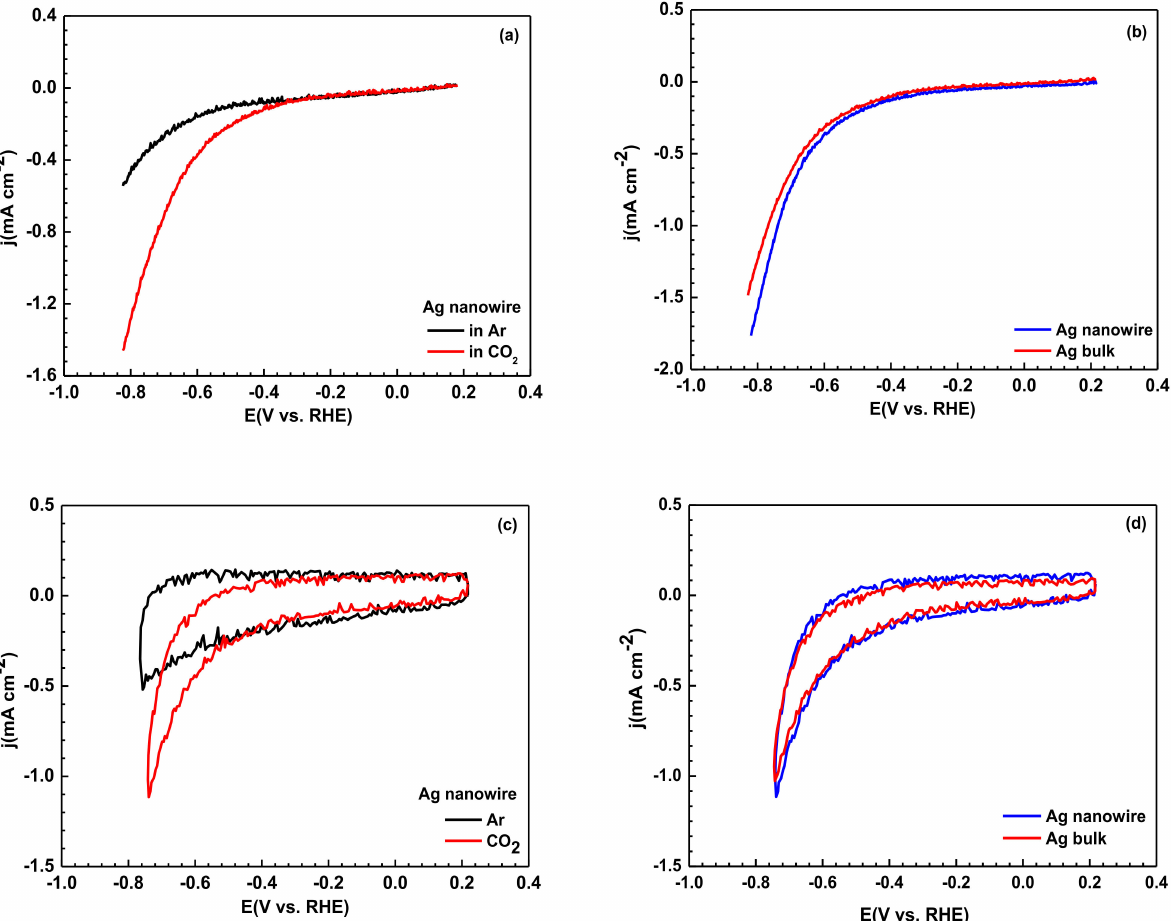
Figure 6. ( a ) LSV for Ag NWs/C in Ar- and CO 2 -saturated 0.1 M KHCO 3 electrolyte; ( b ) LSV for Ag NWs/C and Ag bulk in CO 2 -saturated solution; ( c ) CV for Ag NWs/C in Ar- and CO 2 -saturated 0.1 M KHCO 3 electrolyte; ( d ) CV for Ag NWs/C and Ag bulk in CO 2 -saturated